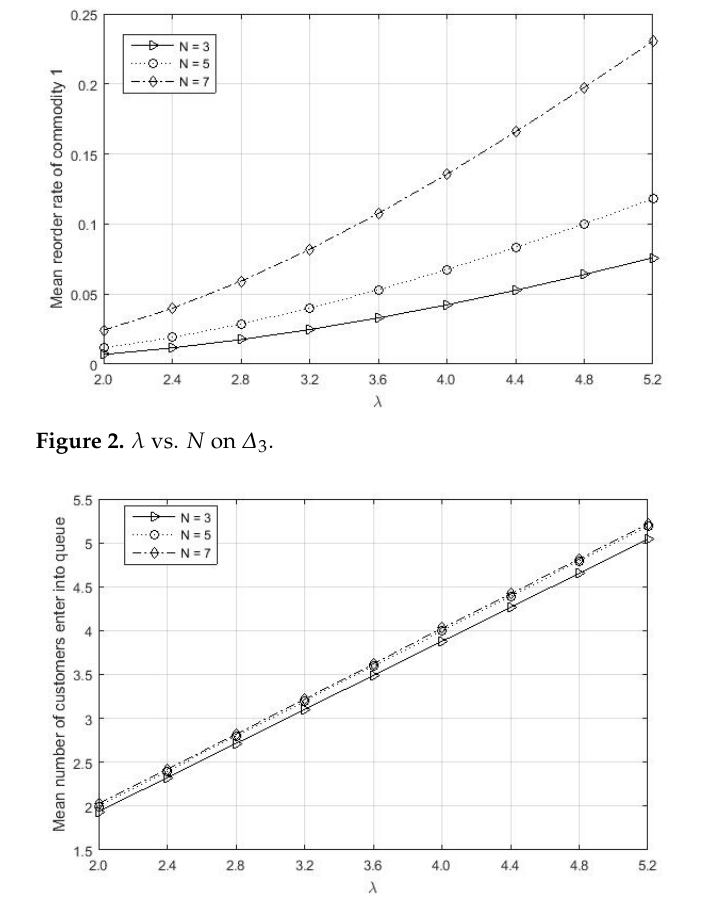
Figure 3. λ vs. N on ∆ 9 .